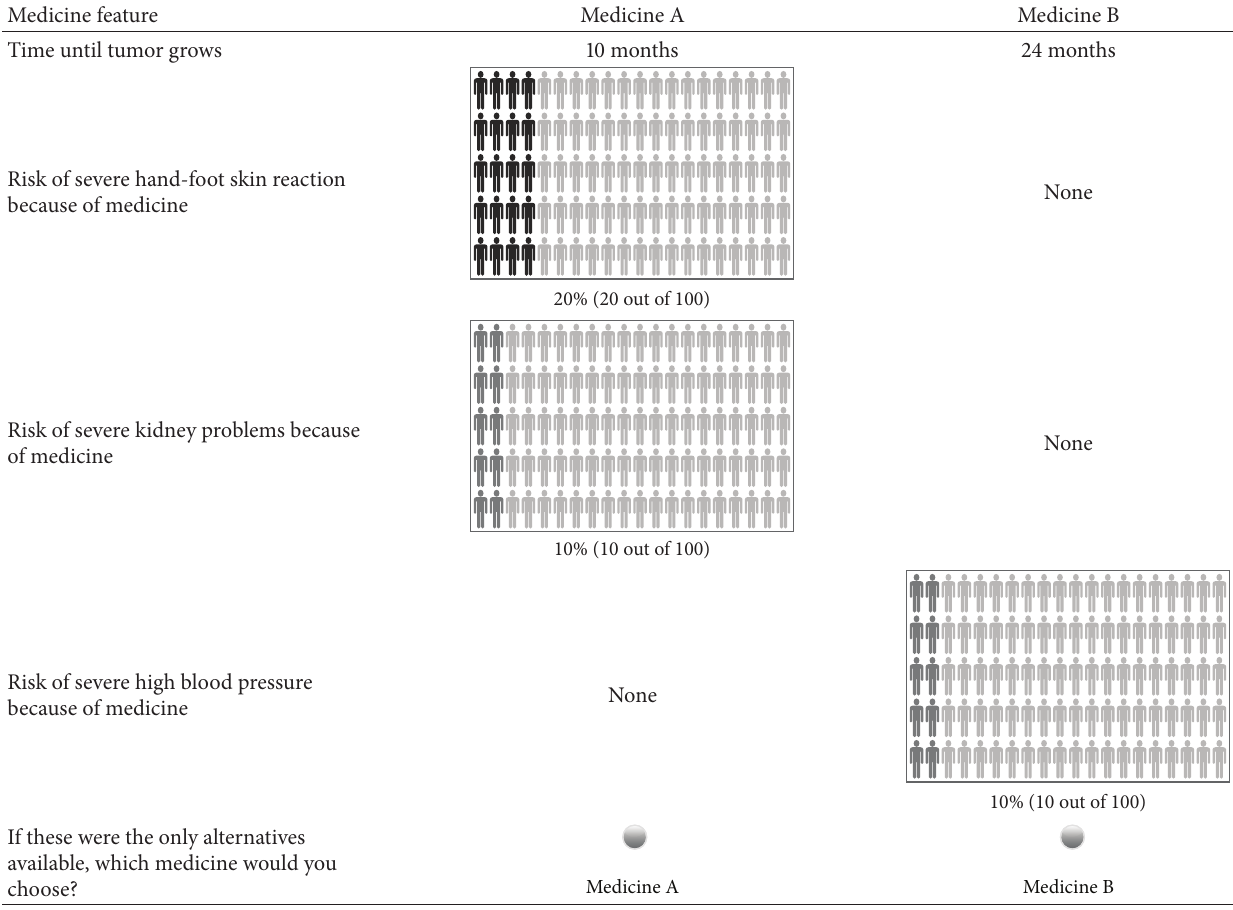
Table 2: Example choice